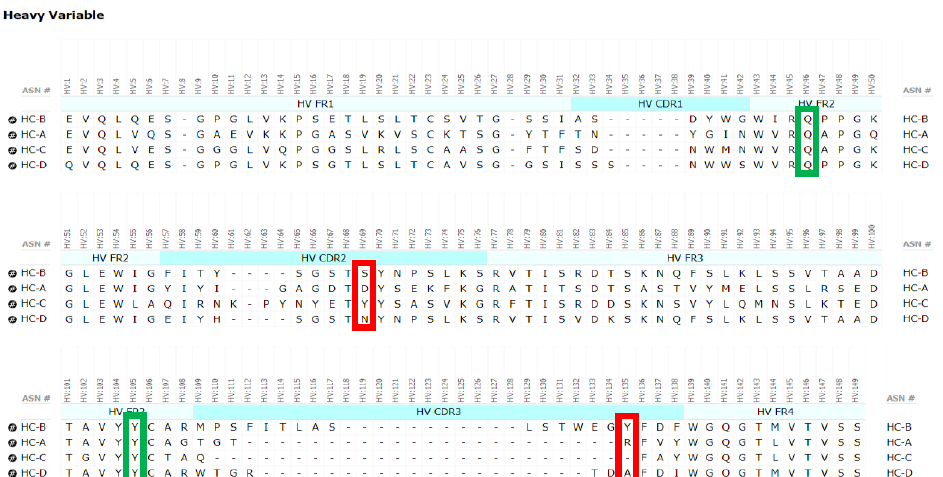
Figure 8. Sequence alignment of the V H domain for the 4 molecules expressed at large scale, or HC- A, -B, -C and -D. Key conserved, interfacial HC2 V H interactions are outlined in red/green. Variable residues where mutagenesis was attempted are indicated with a red box and involve aligned residues in the HC-CDR2 and HC-CDR3. Due to differences in HC-CDR3 lengths which are common, HC2-A R102 was aligned with HC2-C Q99, or the first HC-CDR3 residue. More conserved interfacial contacts where mutagenesis was not attempted are indicated in a green box. Table 6. For mAb HC/LC cotransfection, effect of HC2 formation for both mAb-A and mAb-B is evaluated for each mutant predicted to reduce HC dimer propensity by the Fd2-A crystal structure. % mAb form and % HC2 quantified by NR-cSDS are tabulated along with fold reduction compared to the wild-type version. Lastly, BIAcore affinities of the mAb (KD) towards recombinant target antigen as the analyte are tabulated. Reagent Name